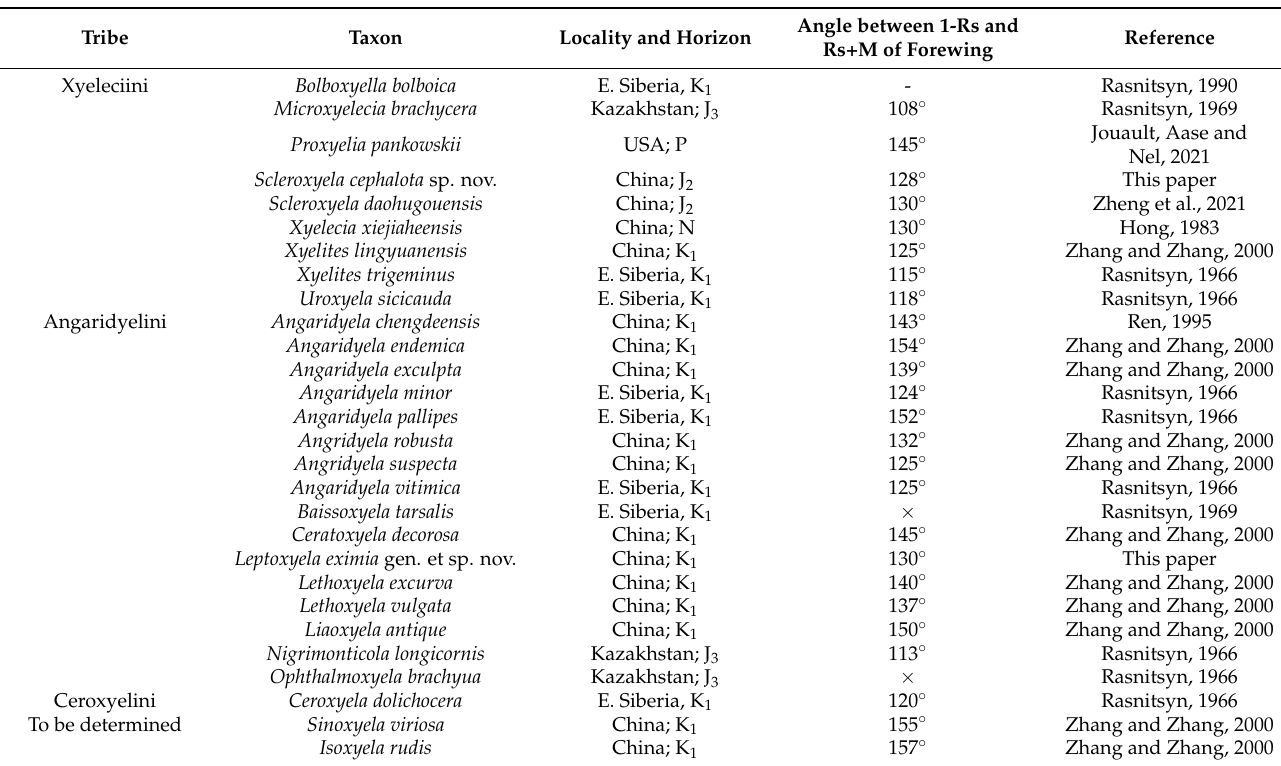
Table 1. Known fossil species of